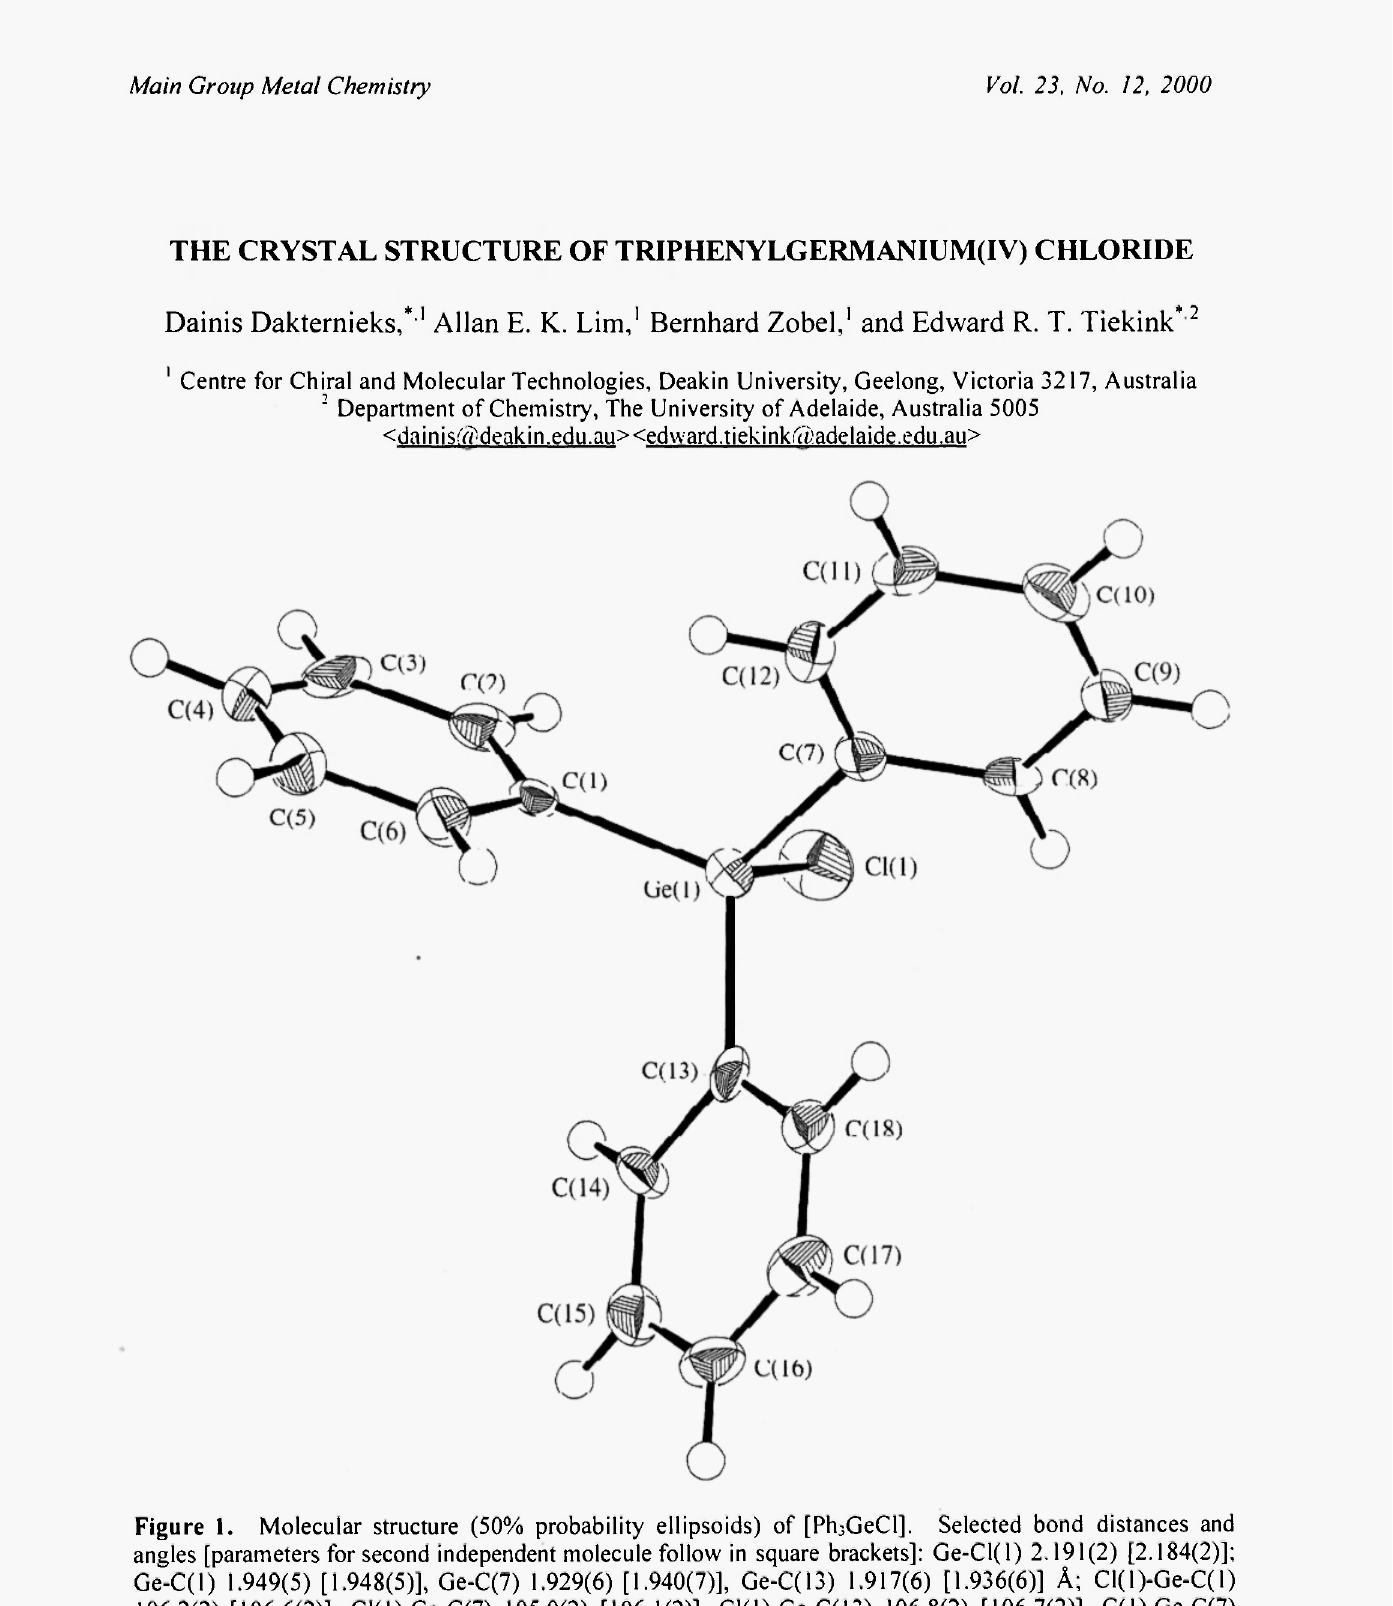
Figure 1. Molecular structure (50% probability ellipsoids) of [Ph 3 GeCl], Selected bond distances and angles [parameters for second independent molecule follow in square brackets]: Ge-Cl(l) 2.191(2) [2.184(2)]; Ge-C(l) 1.949(5) [1.948(5)], Ge-C(7) 1.929(6) [1.940(7)], Ge-C(13) 1.917(6) [1.936(6)] Ä; Cl(l)-Ge-C(l) 106.2(2) [106.6(2)], Cl(l)-Ge-C(7) 105.0(2) [106.1(2)], Cl(l)-Ge-C(13) 106.8(2) [106.7(2)], C(l)-Ge-C(7) 114.0(3) [109.1(2)], C(l)-Ge-C(13) 111.0(2) [112.0(3)], C(7)-Ge-C(13) 113.1(3)